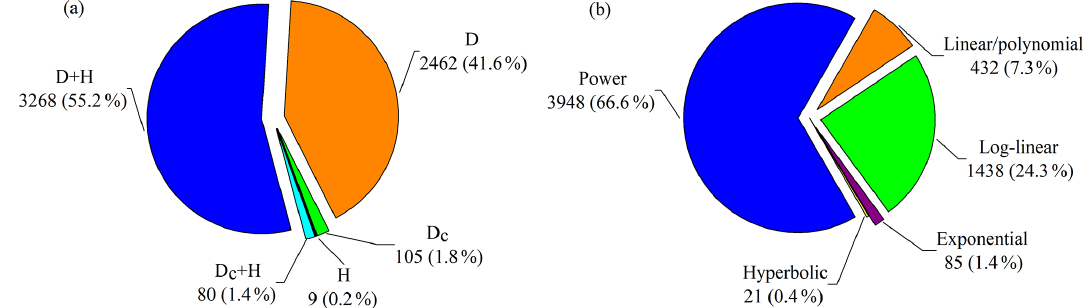
Figure 4. Distribution of compiled biomass equations by (a) predictor variable and (b) equation form. D and H are diameter at breast height (1.3m) and height, and D c is tree diameter at heights (e.g., 0, 0.2 and 0.3m) other than breast height. Equation forms used in original studies are categorized into power equation, log-linear equation, linear/polynomial equation, exponential equation and hyperbolic equation (Appendix E).